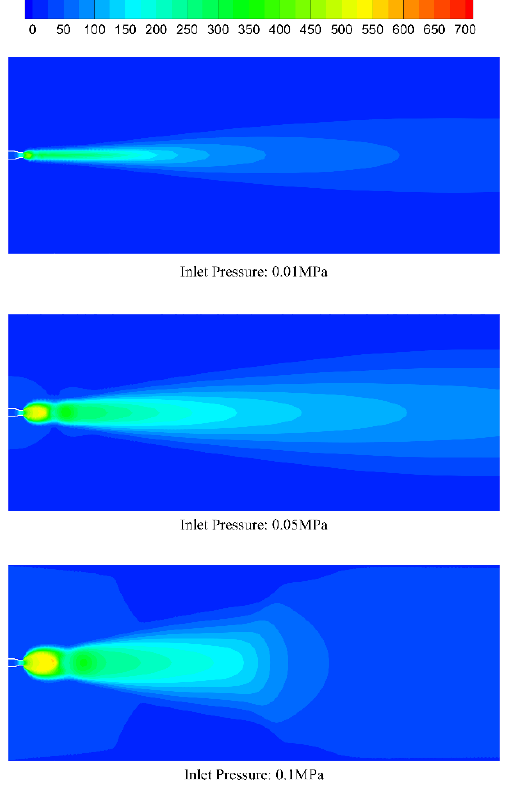
Figure 3. Velocity contours of nozzle #2 at different inlet pressures (m/s).